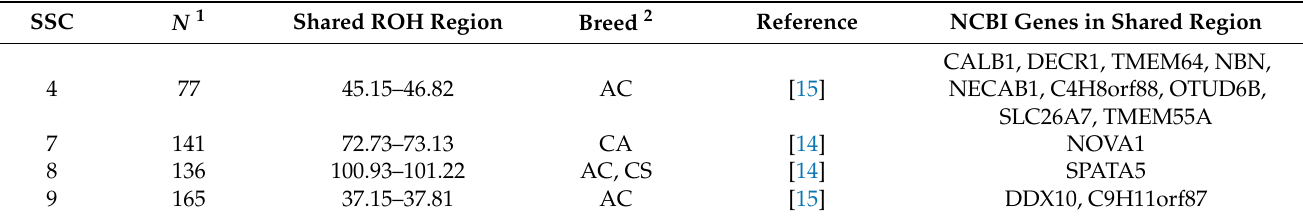
Table 6. Genes located in common ROH shared by Nero Lucano and Italian black pigs.